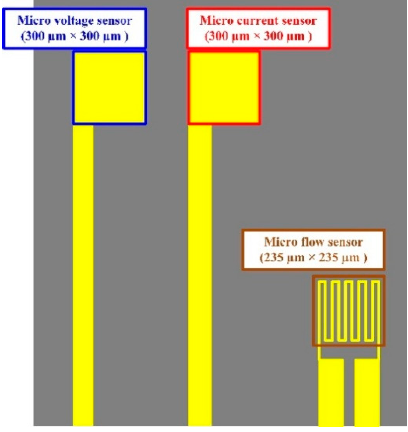
Figure 4. Design drawing of a flexible integrated microsensor.